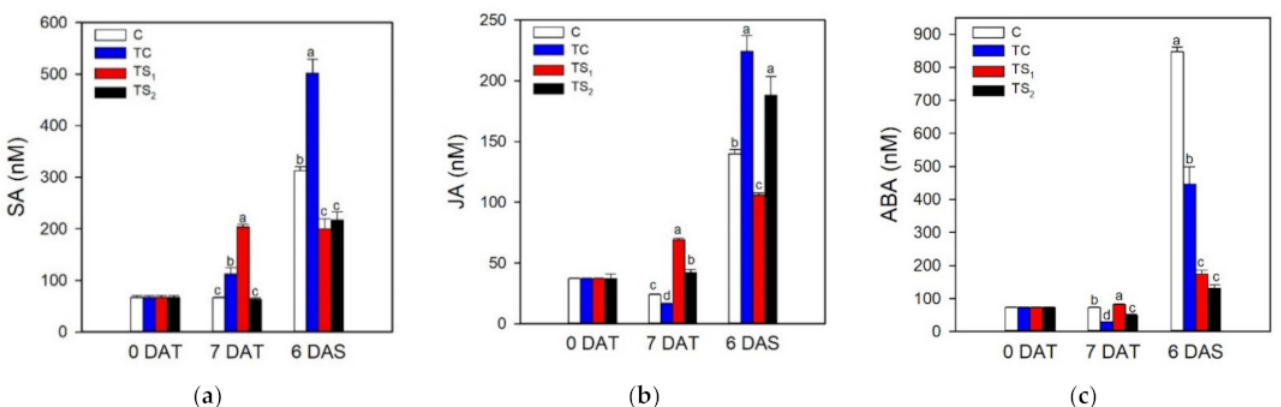
Figure 1. Hormonal content (nM) in the xylem sap of purple basil cv. Red Rubin at 0 and 7 days after bacterial treatment (0 DAT and 7 DAT, respectively) and at 6 days after water stress (6 DAS): ( a ) salicylic acid (SA); ( b ) jasmonic acid (JA); ( c ) abscisic acid (ABA). Values are means ± SE ( n = 3). Different letters indicate significant differences among bacterial treatments and control (one-way ANOVA with Fisher’s LSD test, p ≤